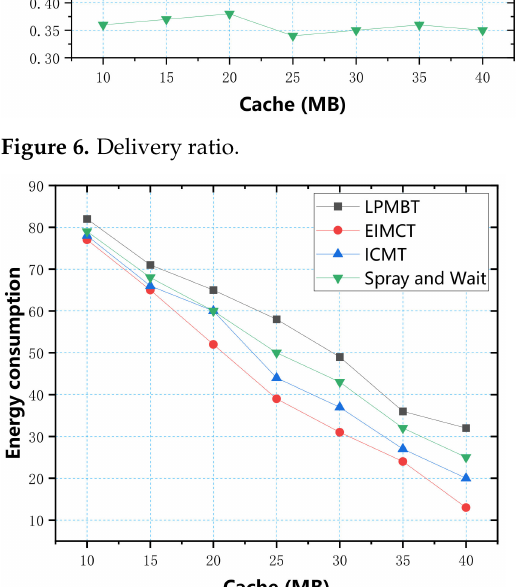
Figure 7. Energy